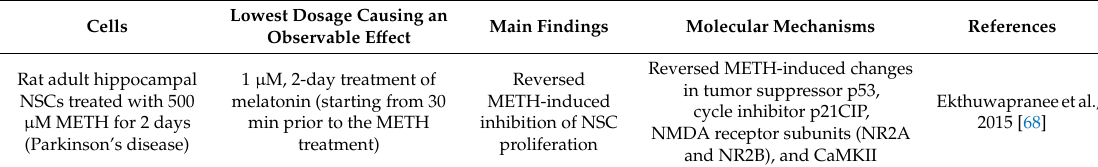
Table 5. Table showing the main findings regarding the e ff ects of melatonin on neurogenesis in neurodegenerative disease(s) and the respective molecular mechanisms in the in vitro studies. Lowest Dosage Causing an Main Findings Molecular Cells Observable E ff ect